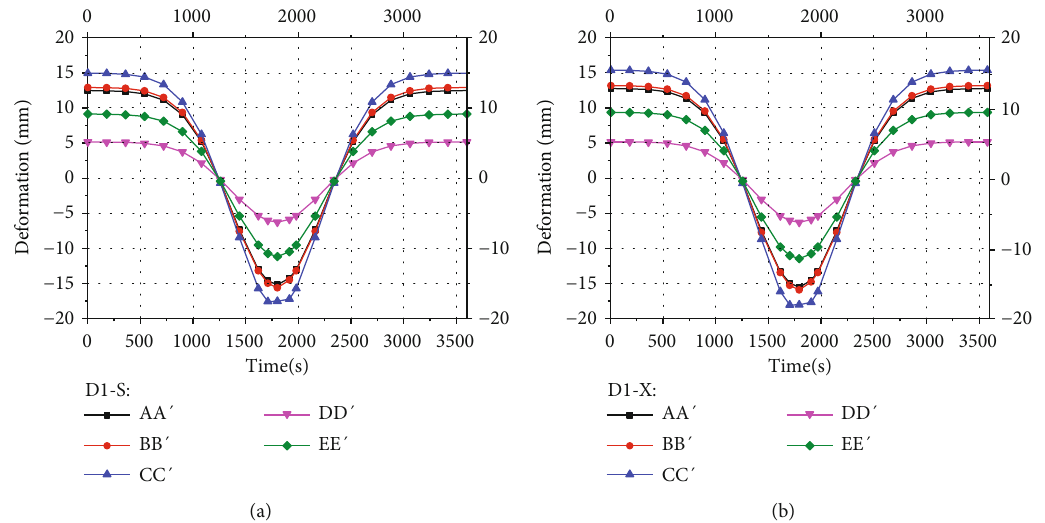
Figure 13: Thermal deformation curves of the centroid at di ff erent constraints. (a) Deformation of centroid D1-S. (b) Deformation of centroid